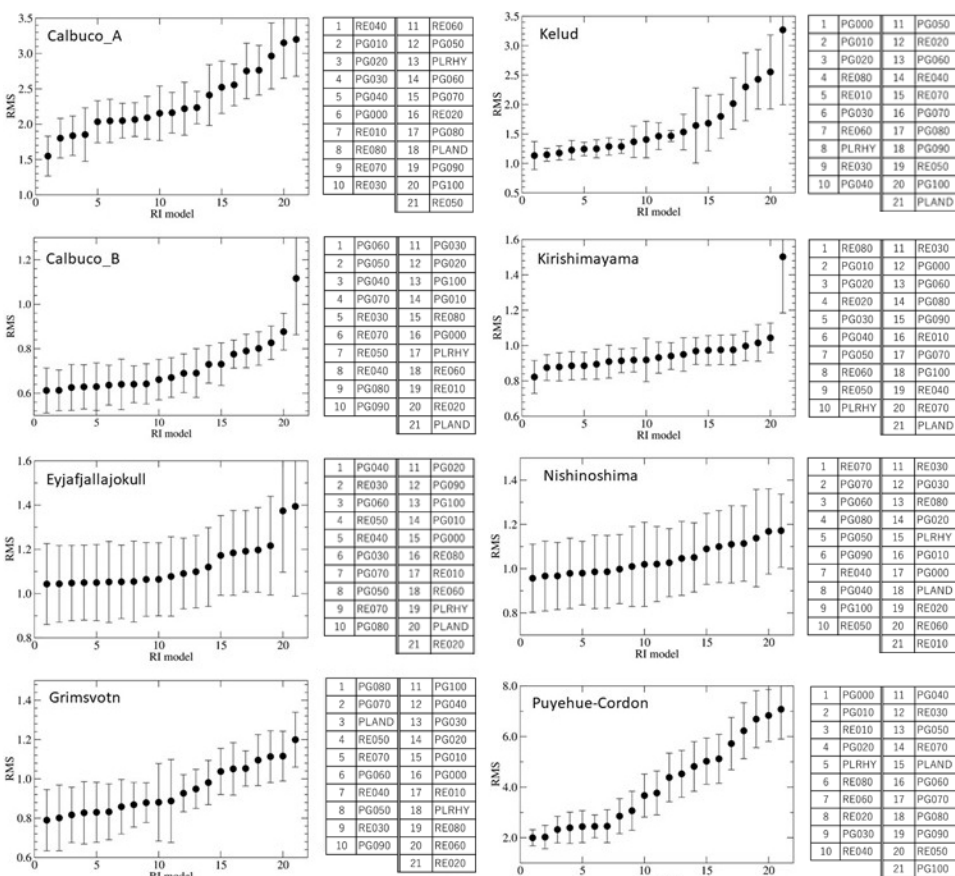
Figure 9. Results of the rms (filled circle) for each RI model averaged over the pixels of the eruptions in Table 2. The error bar indicates the standard deviation. The RI models are arranged in order from smallest to largest rms from left to right, and the corresponding RI models are listed on the